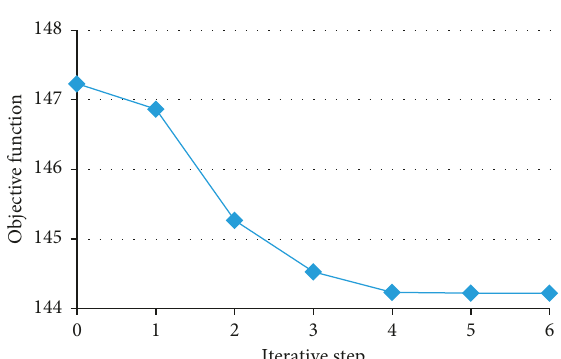
Figure 16: Iterative process of objective function.